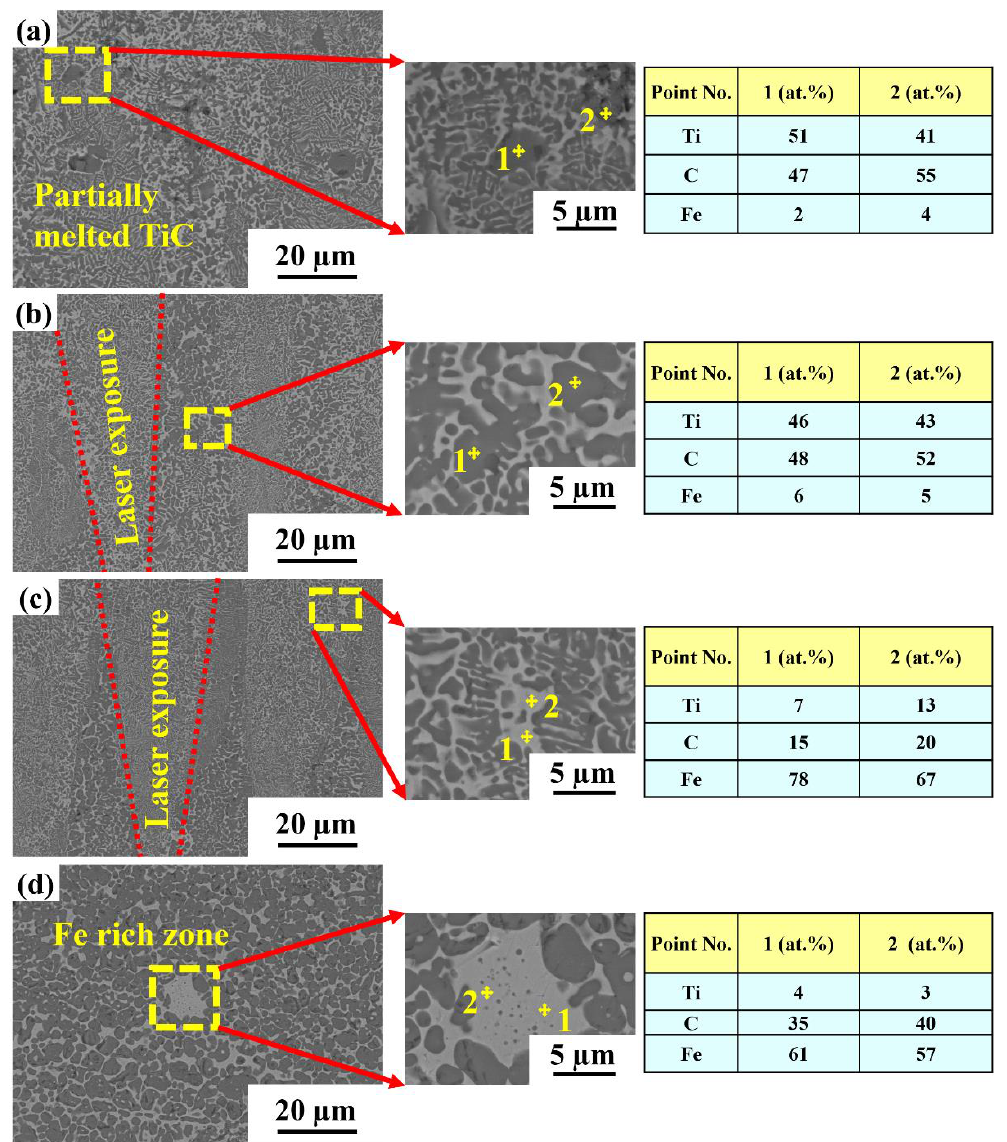
Figure 5. Scanning electron micrograph of the longitudinal section/side view and energy dispersive spectrum point analysis of the SLM processed cermets fabricated with different laser melting peak power ( a ) LMP50, ( b ) LMP60, ( c ) LMP70, and ( d ) LMP84.